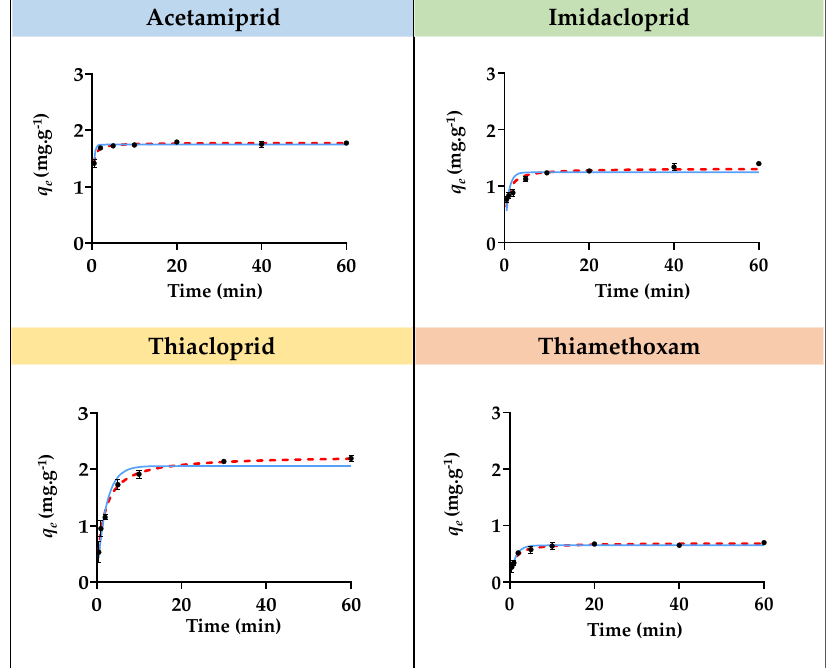
Figure 2. Adsorption kinetics curves for acetamiprid, imidacloprid, thiacloprid, and thiamethoxam insecticides with [Si][N 3444 ]Cl. The black dots correspond to the experimental data, the continuous blue line corresponds to the fitting of the experimental data with the Pseudo first ‐ order model, and the red dashed line corresponds to the fitting with the Pseudo second ‐ order model.